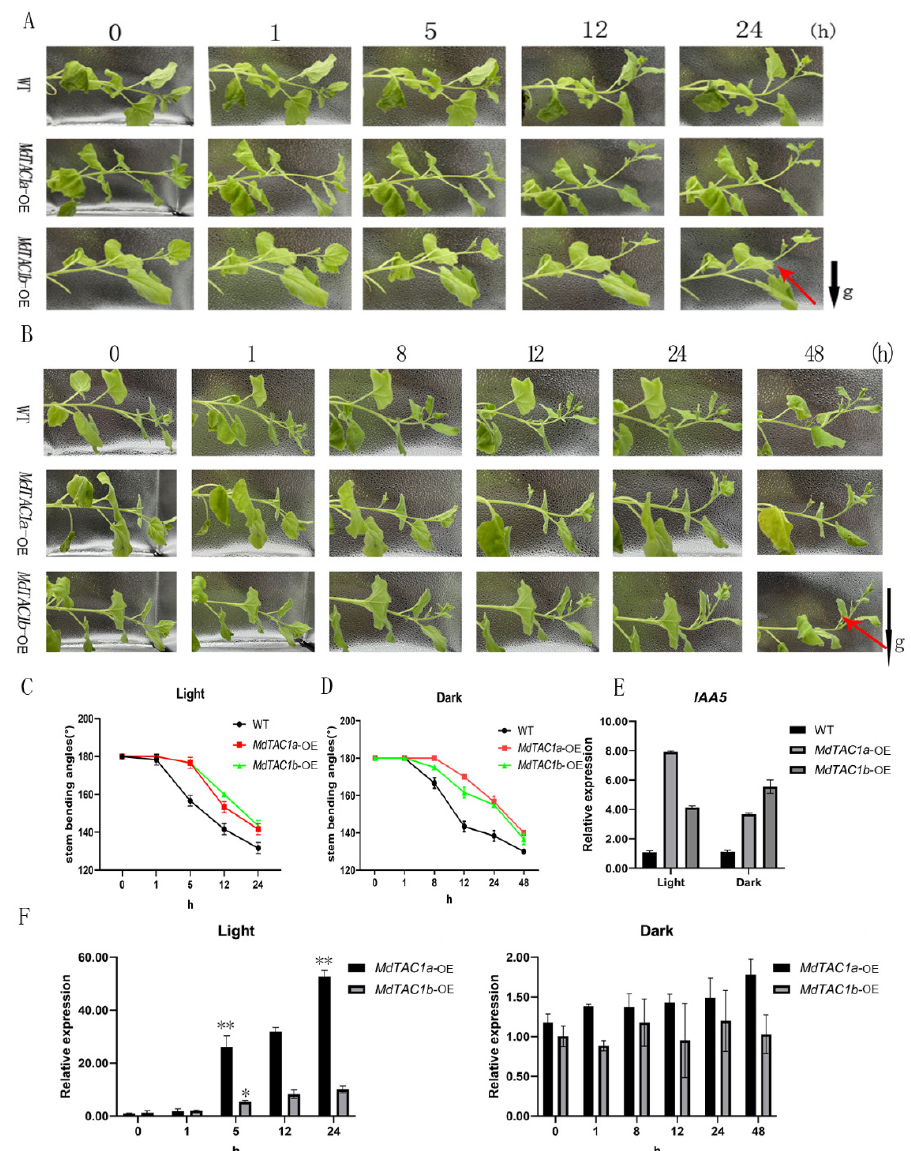
Figure 4. Gravitropic and light responses in wild-type (WT), MdTAC1a -OE, and MdTAC1b -OE tobaccos. ( A , B ) Tobacco responded to gravity for 24 h under light and 48 h for darkness. ( C , D ) The angle in the stem was bent at the position of the red arrow in ( A , B ). Bars indicated the means ± SDs ( n = 3). ( C ) The statistics of the degree of bending of plant stems placed horizontally under light at 0, 1, 5, 12, and 24 h. ( D ) The statistics of the degree of bending of plant stems placed horizontally at 0, 1, 8, 12, 24, and 48 h in the dark. The rate of stem bending was faster in WT than in MdTAC1a -OE and MdTAC1b -OE plants, regardless of light or dark treatments. ( E ) The relative expression level of IAA5 in the stem at the position of the red arrow in ( A , B ). ( F ) Dynamic changes in relative expression levels of MdTAC1a and MdTAC1b in OE plants during stem-bending period under light and dark condition . The results showed the gene relative expression in the MdTAC1a and MdTAC1b trans- genic lines was significantly more than that of the wild type in tobacco. The significance of difference was analyzed with two-tailed t-test (* 0.01 < p < 0.05, ** p < 0.01). Data were represented as average values with SD. After 0, 1, 8, 12, 24, and 48 h of horizontal placement in darkness, plants were imaged, and the stem angle was measured. The time required for WT and OE plants to bend up- ward in the dark was later than that of corresponding plants exposed to light, indicating